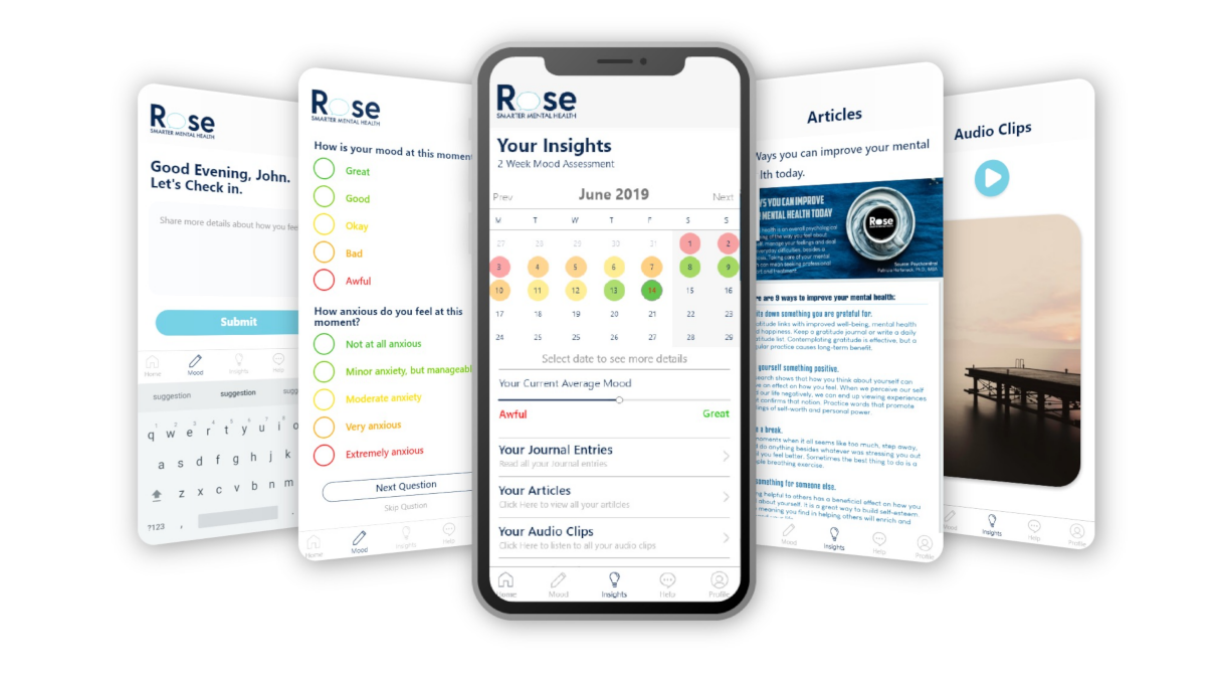
Figure 1. Rose mobile app